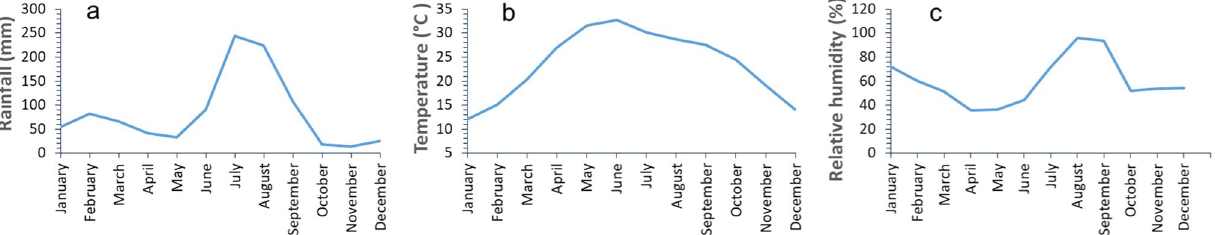
Fig. 3 The monthly rainfall time series is shown in a , the monthly temperature series is shown in b , and the monthly relative humidity is shown in